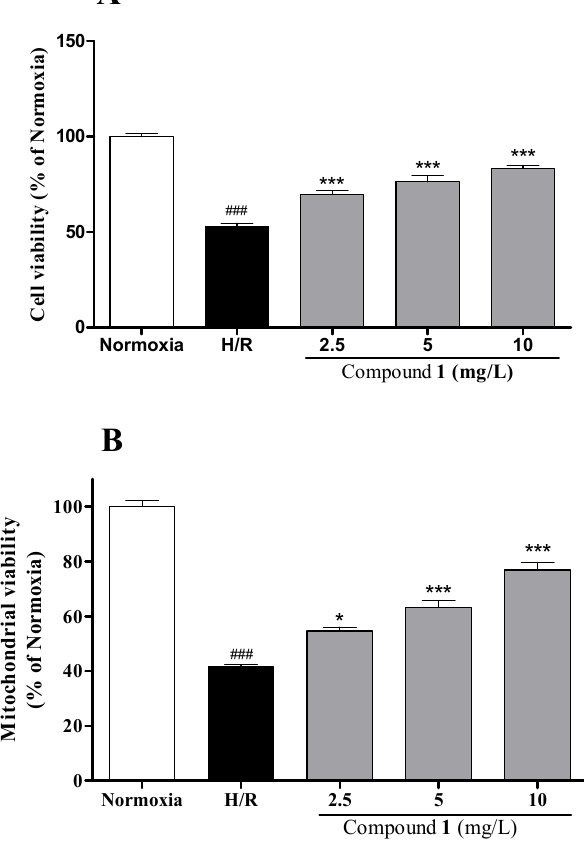
Figure 3. Effects of compound 1 on hypoxia/reoxygenation (H/R)-induced injury in H9c2 cells. ( A ) Cell viability was determined by 3-(4,5-dimethylthiazol-2-yl)-2,5-diphenyltetrazolium bromide (MTT) assay. Cell viability of normal group was considered as 100%; ( B ) Mitochondrial viability was determined by florescent staining. Data represent mean ± SEM. The results were reproduced by six independent experiments. ### indicates p < 0.001 for the H/R group vs. normoxia group; * indicates p < 0.05, *** indicates p < 0.001 for each treatment group vs. the H/R group.